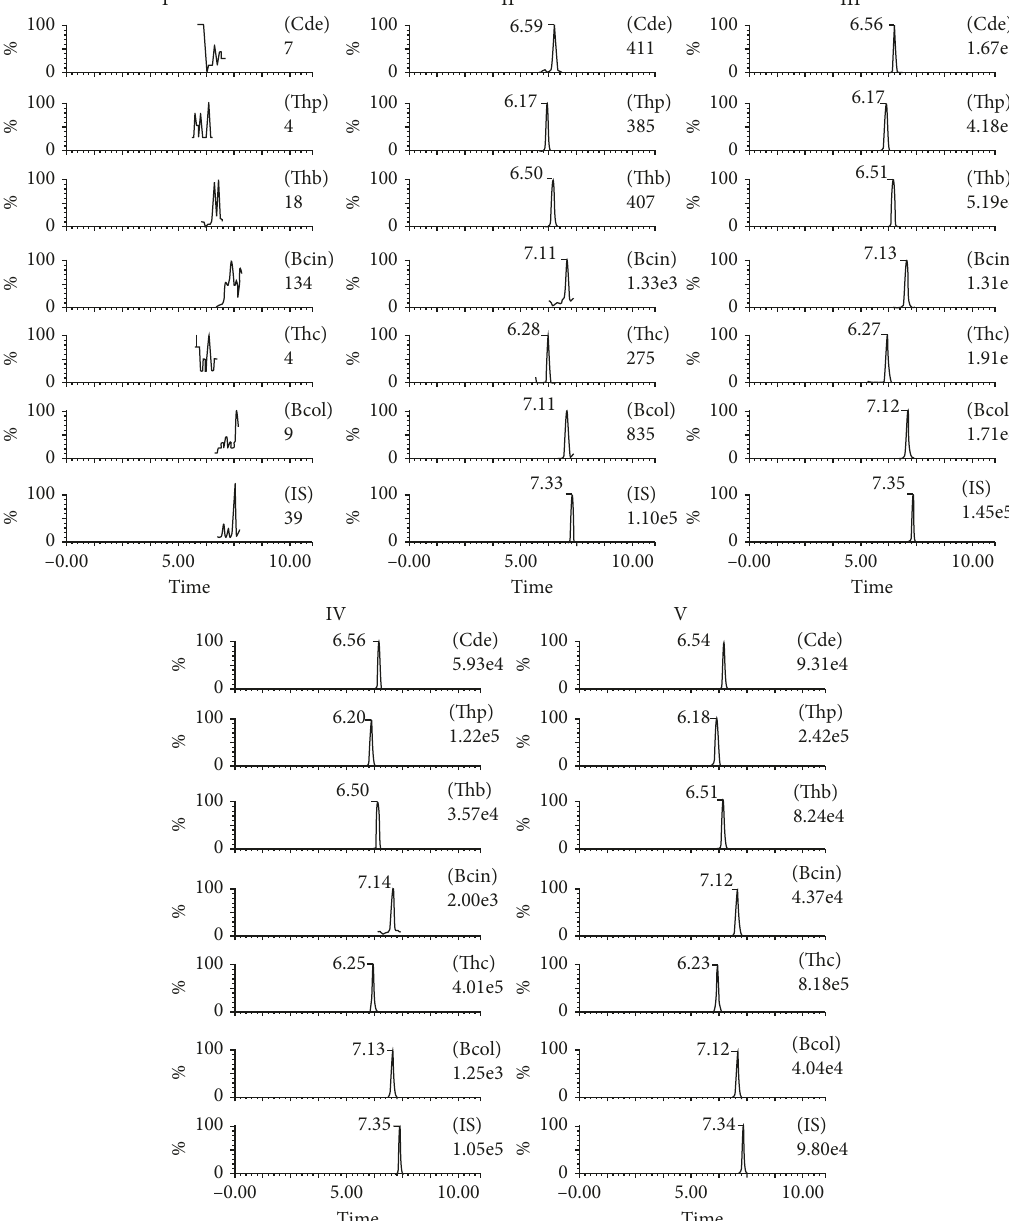
Figure 2: MRM chromatograms of the analytes and IS: (I) blank dog plasma; (II) blank dog plasma spiked with the analytes at LLOQ and IS; (III) plasma sample after oral administration of YHZT OL at 0.667h; (IV) plasma sample after oral administration of YHZT DTat 0.667h; (V) plasma sample after oral administration of YHZT DP at